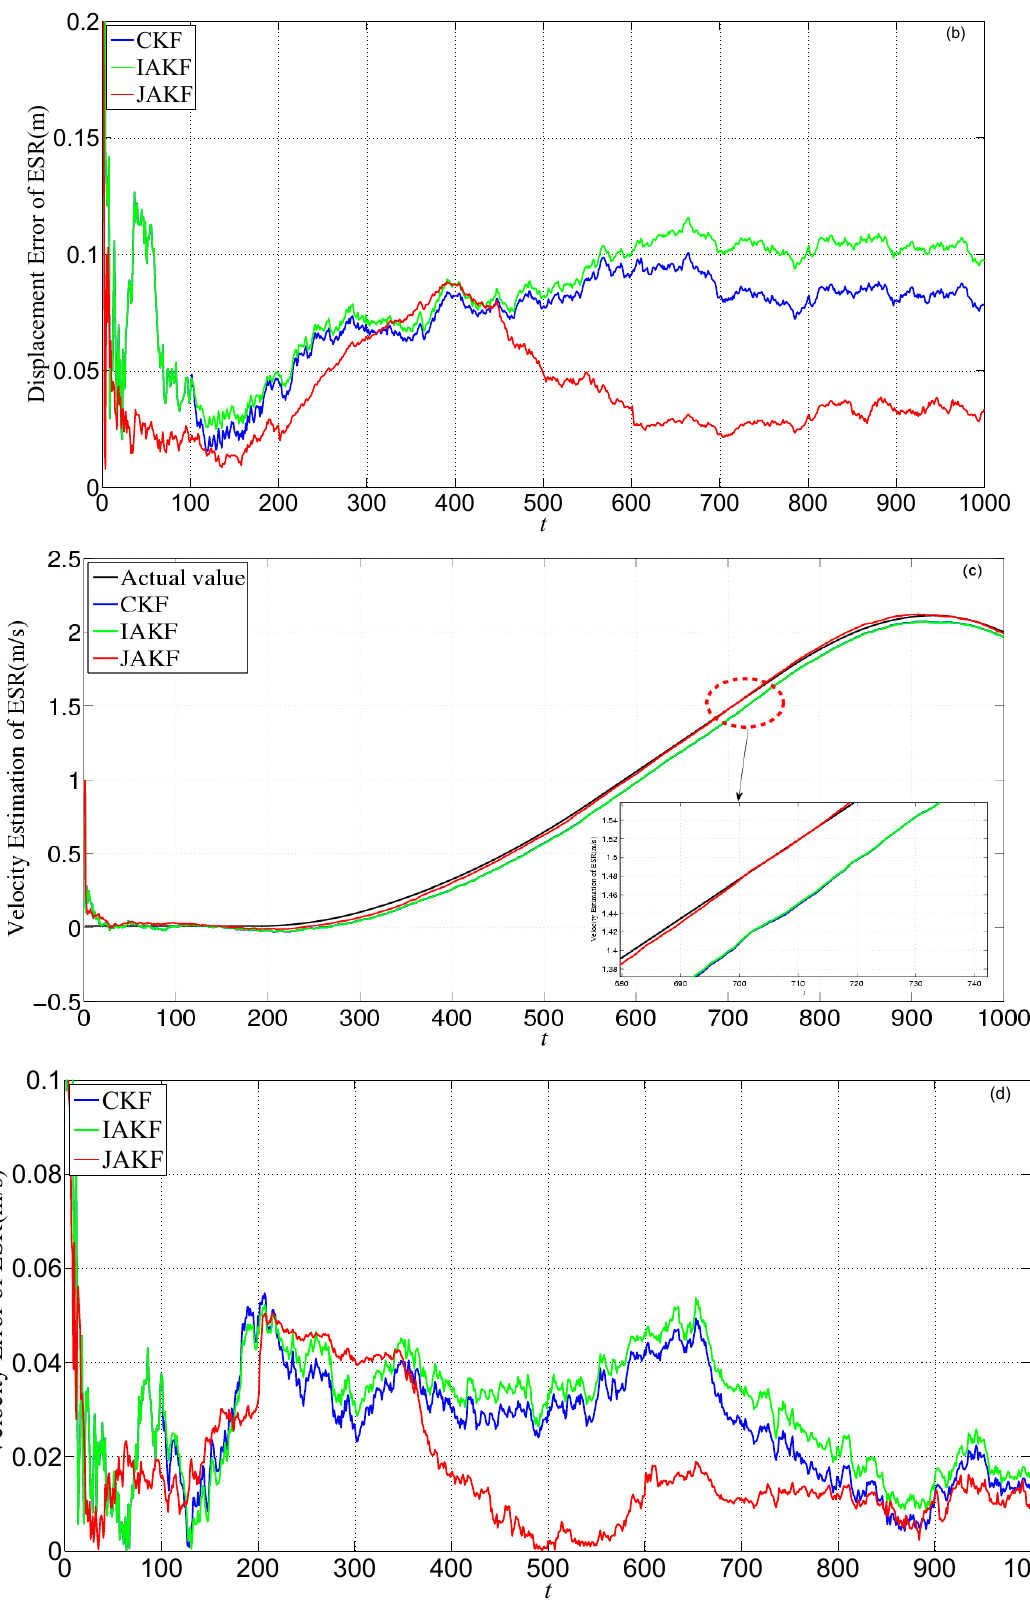
Figure 19. Cont . Figure 19.